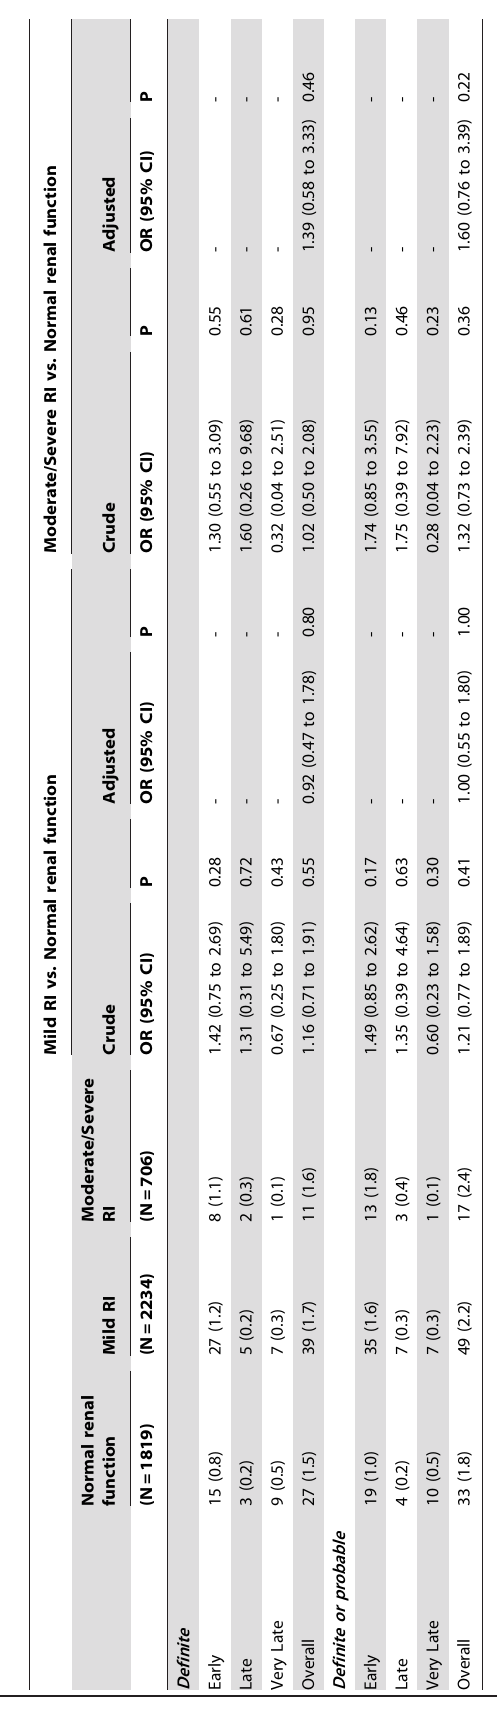
( Table 4 ). Similarly, no differences between groups were observed in rates of ST during the early (0–30 days), late (31 days-1 year), and very late ( . 1 year) follow-up period. Effectiveness Outcomes The risk of repeat revascularization did not differ between patients with moderate/severe RI, mild RI and those with normal renal function, in terms of both TLR (moderate/severe RI vs. normal renal function adjusted OR = 1.17, 95%CI 0.70–1.95, P= 0.55; mild RI vs. normal renal function adjusted OR =1.16,